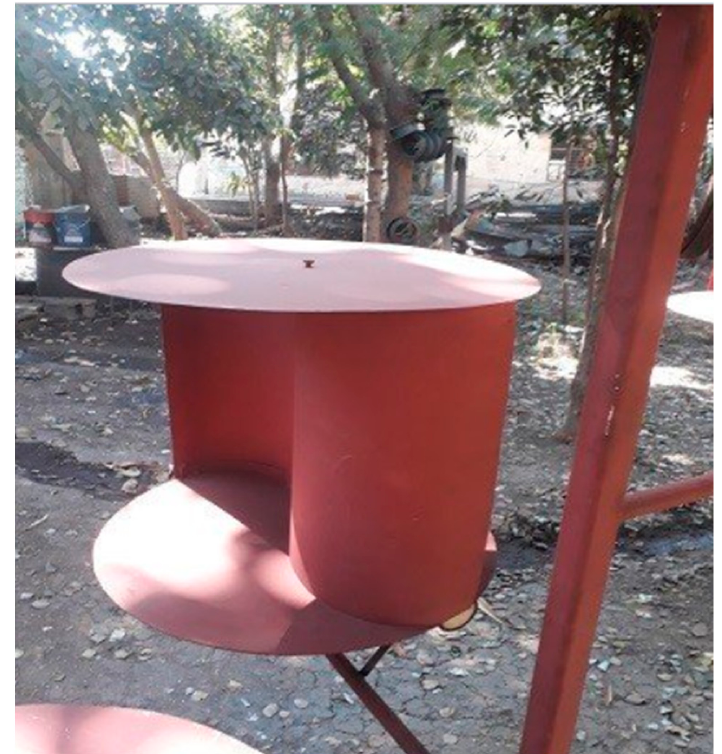
Figure 3. Actual Savonius rotor blade.